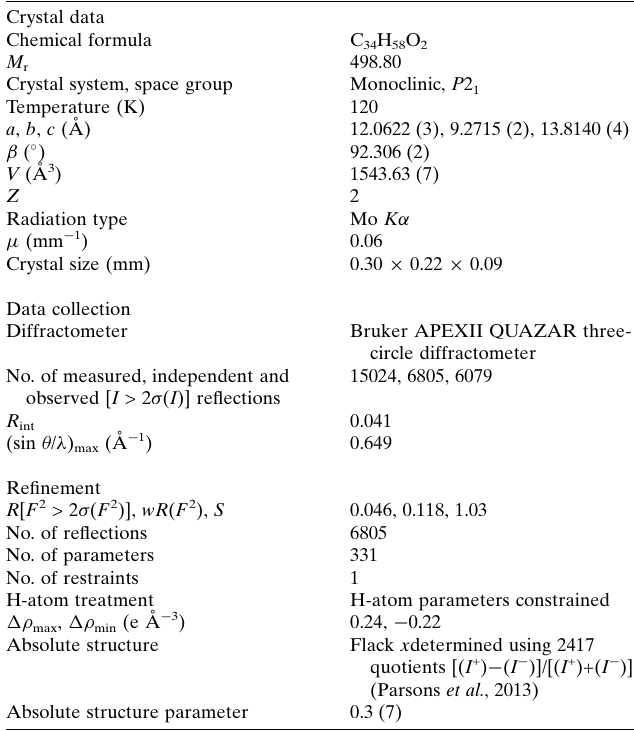
Table 4 Experimental details. Crystal data Chemical